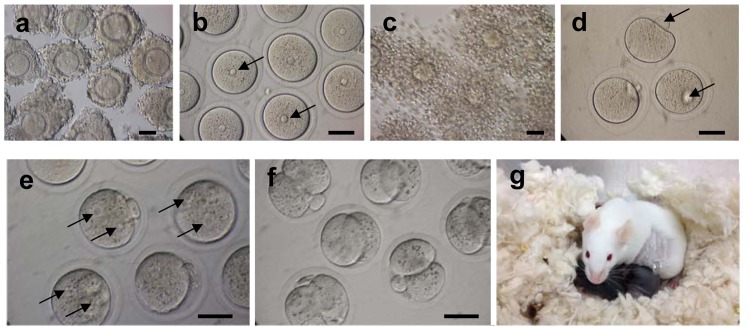
Developmental competence of full-size GV oocytes grown under 3-D culture system.
(a) After 10 days of the 3-D ovarian tissue culture (M+A), GV oocytes surrounded by granulosa cells were isolated from the antral follicles for in vitro maturation (IVM). (b) To observe germinal vesicles (arrows) in GV oocytes, surrounding granulosa cells were mechanically removed. (c) After IVM, granulosa cell layers surrounding the oocytes underwent expansion. (d) To observe first polar bodies (arrows) in matured MII oocytes, expanded granulosa cell layers were removed after IVM. (e) In vitro matured oocytes with expanded granulosa cells were subjected to in vitro fertilization (IVF). Six hrs after IVF, two pronuclei (arrows) were observed in each fertilized oocyte. (f) Twenty-four hrs after IVF, some of fertilized oocytes developed to the 2-cell stage embryos. (g) The 2-cell embryos were transferred to surrogate mothers to obtain full-term offspring with black coat color. Bar = 40 μm.